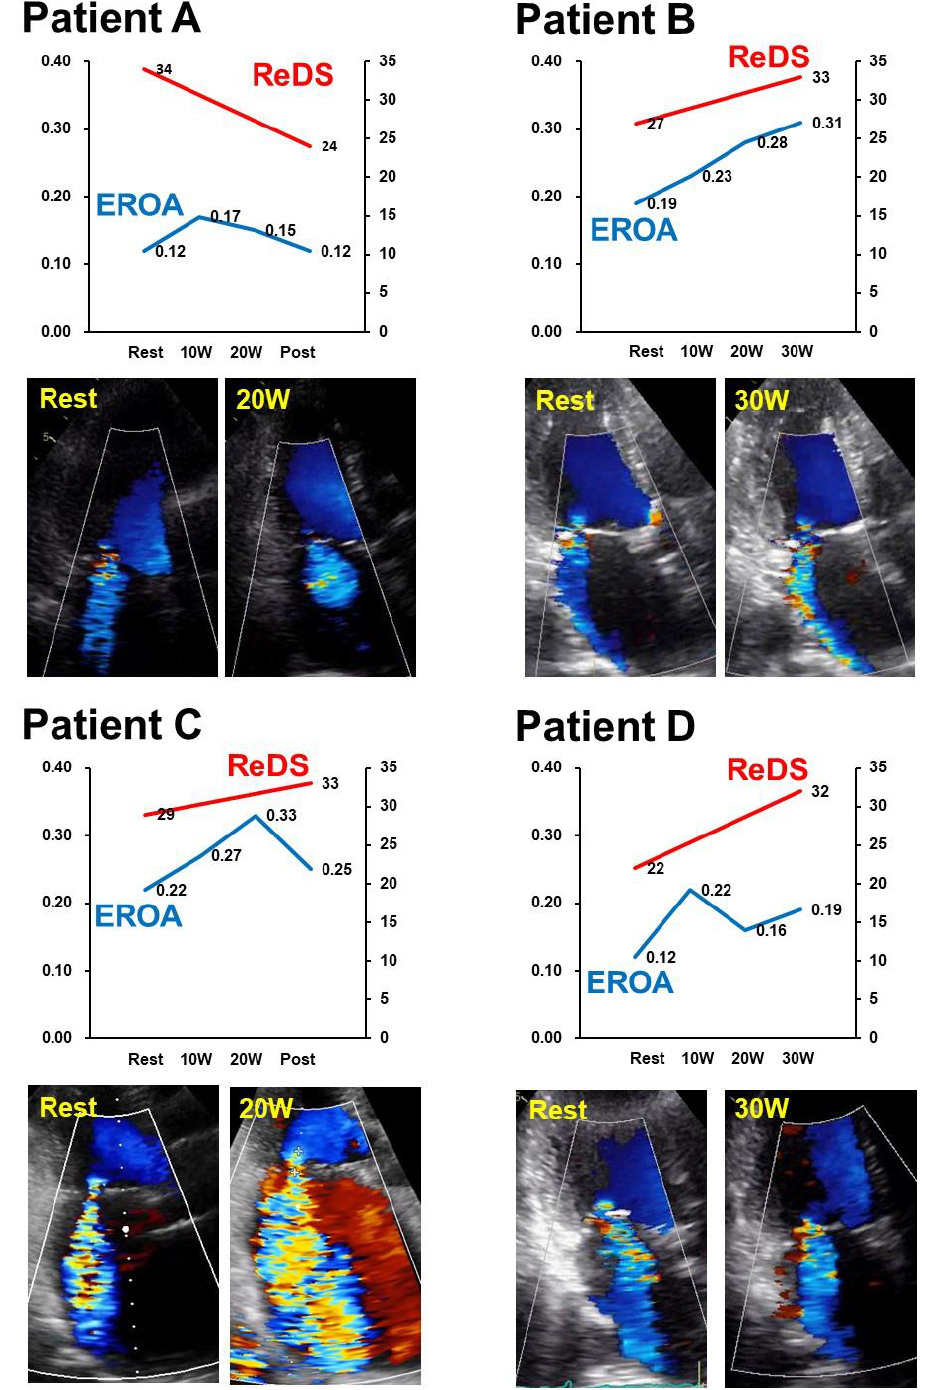
Figure 2. Trends of ReDS values and EROA during stress testing in the included four cases ( A – D ). ReDS, remote dielectric sensing; EROA, effective regurgitant orifice area.